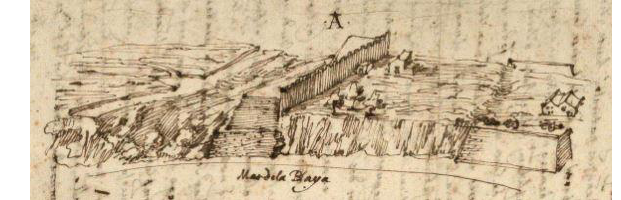
Figure 2. Drawing of the city of Cadiz on a shutter that they have opened in the fortress and on the wall, 1513.